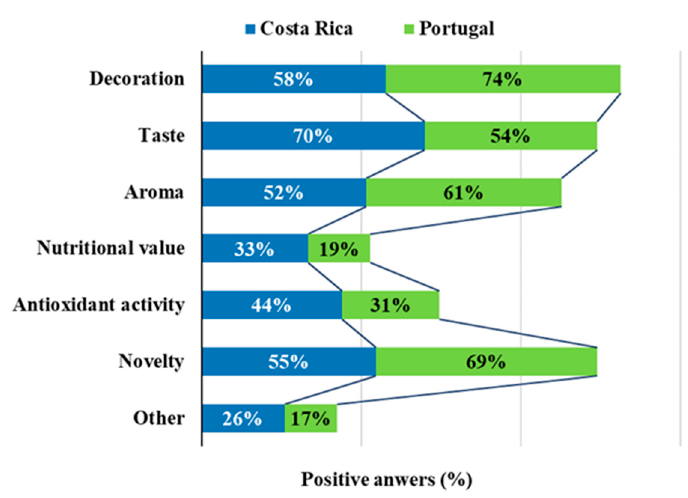
Figure 3. Reasons pointed out by the participants for consumption of EF.